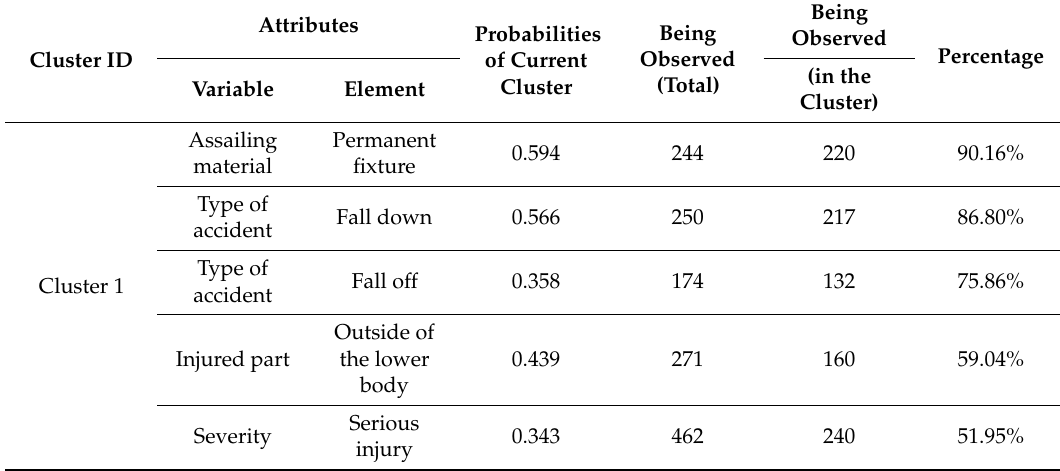
Table 6. Five most influential variables and elements in the formation of each